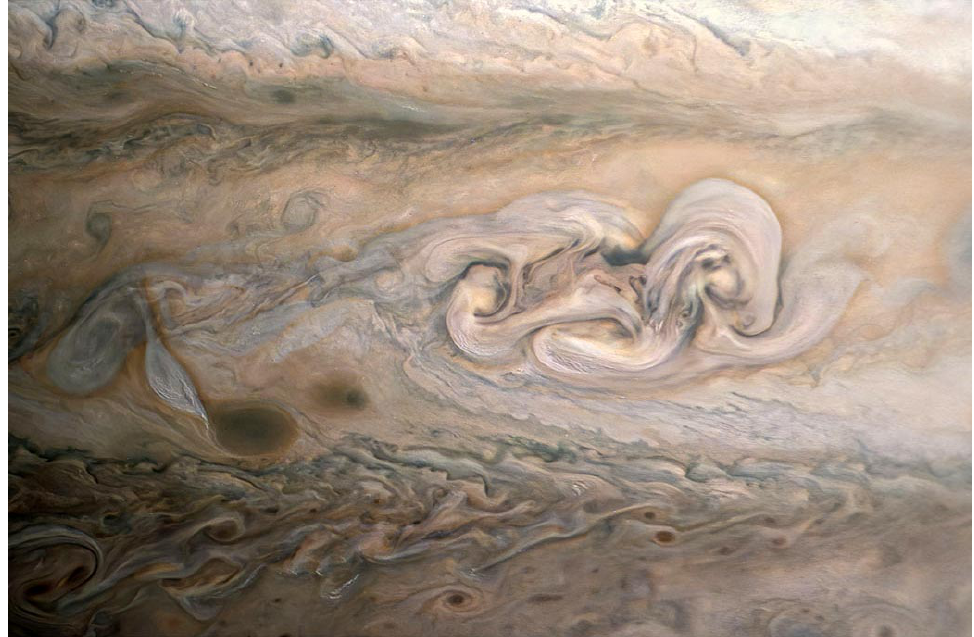
Figure 3. The Folded Filamentary Region (FFR) state of the Clyde’s spot observed almost a year after it was first identified. Credits: NASA/JPL-Caltech/SwRI/MSSS/Kevin